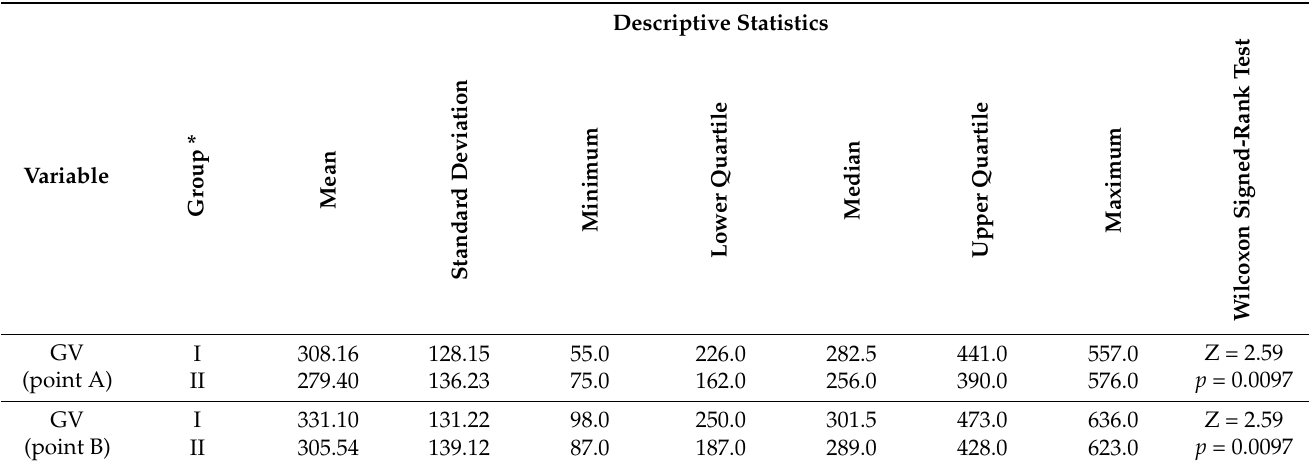
Table 4. Mean values of GVs in